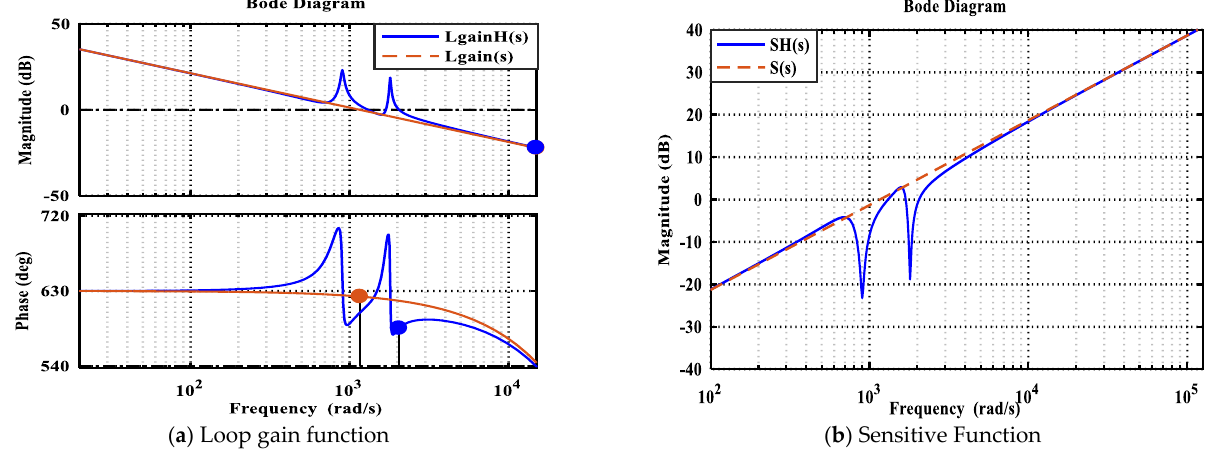
Figure 6. Bode diagram performance comparison of the traditional Robust-TDOF and Robust-TDOFR controller: ( a ) loop gain function and ( b ) sensitive function.